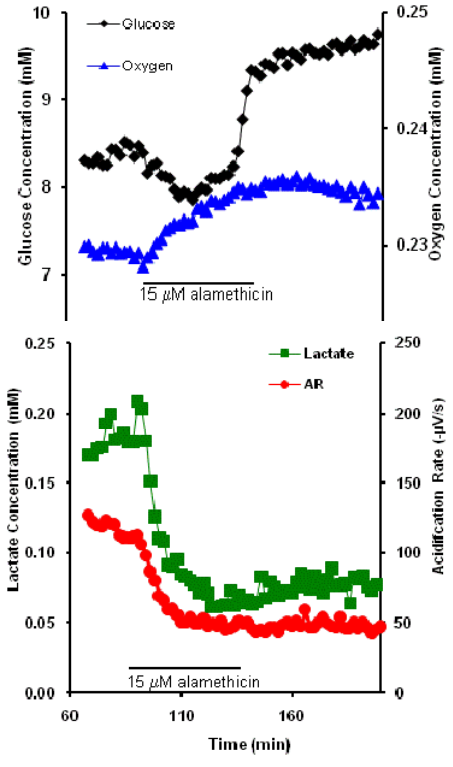
Figure 3. Representative effect of 15 mM alamethicin on RAW macrophage